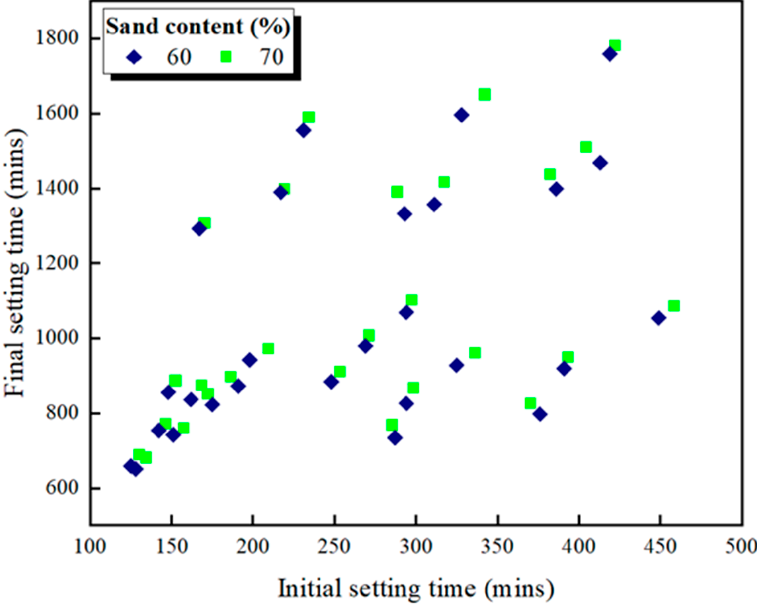
Figure 6. Setting time of green and ecofriendly grouting material.